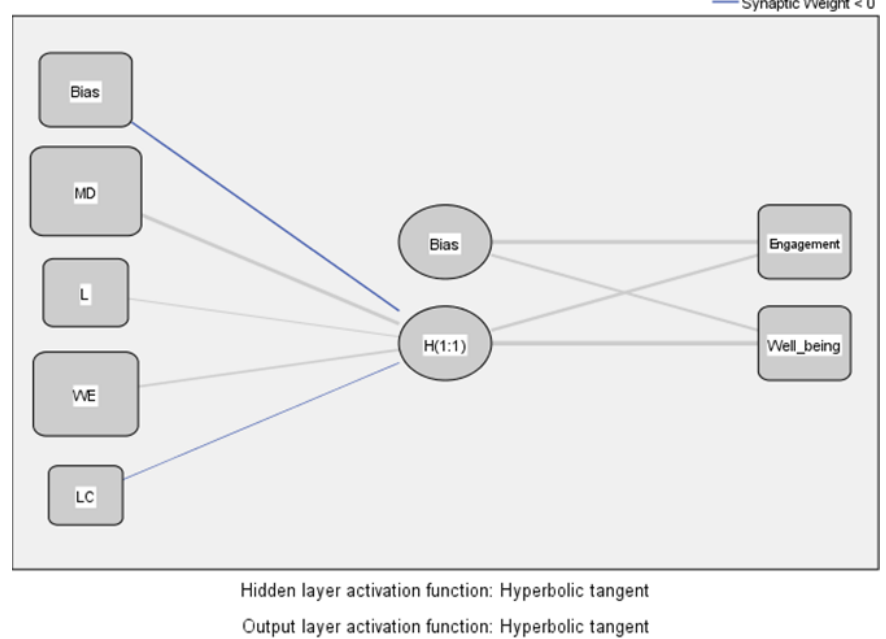
Figure 5. MLP model for identifying the influences of EE dimensions on the overall level of EE and WB. Source: Developed using SPSS v.20 (SPSS Inc., Chicago, IL, USA).